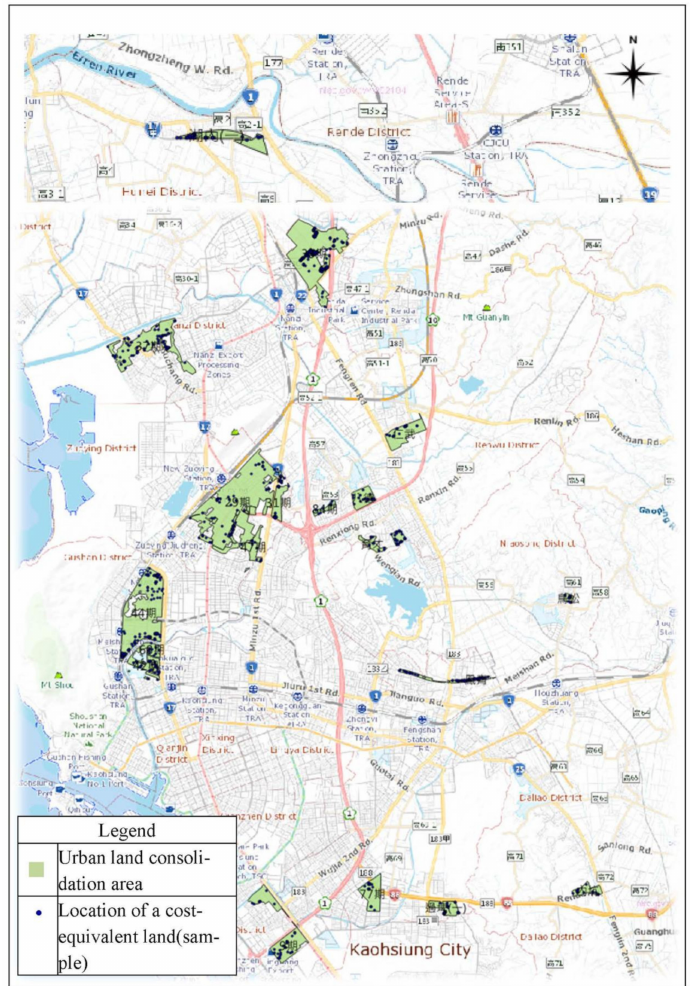
Figure 1. Location of the 19 urban land consolidation areas and cost-equivalent lands in the